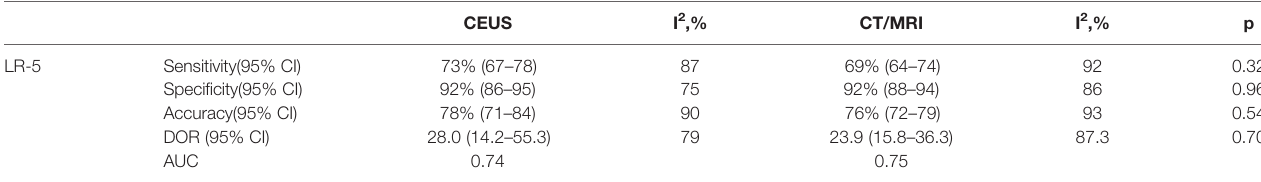
TABLE 3 | Diagnostic performance of CEUS and CT/MRI LR-5 for HCCs.